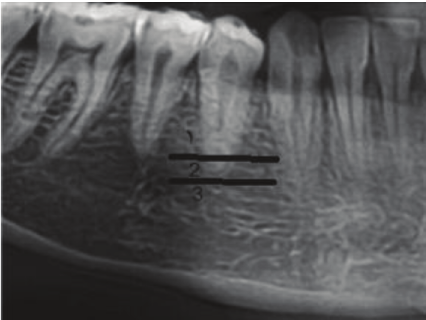
Figure 1: The vertical position of mental foramen image in relation to the dental root.